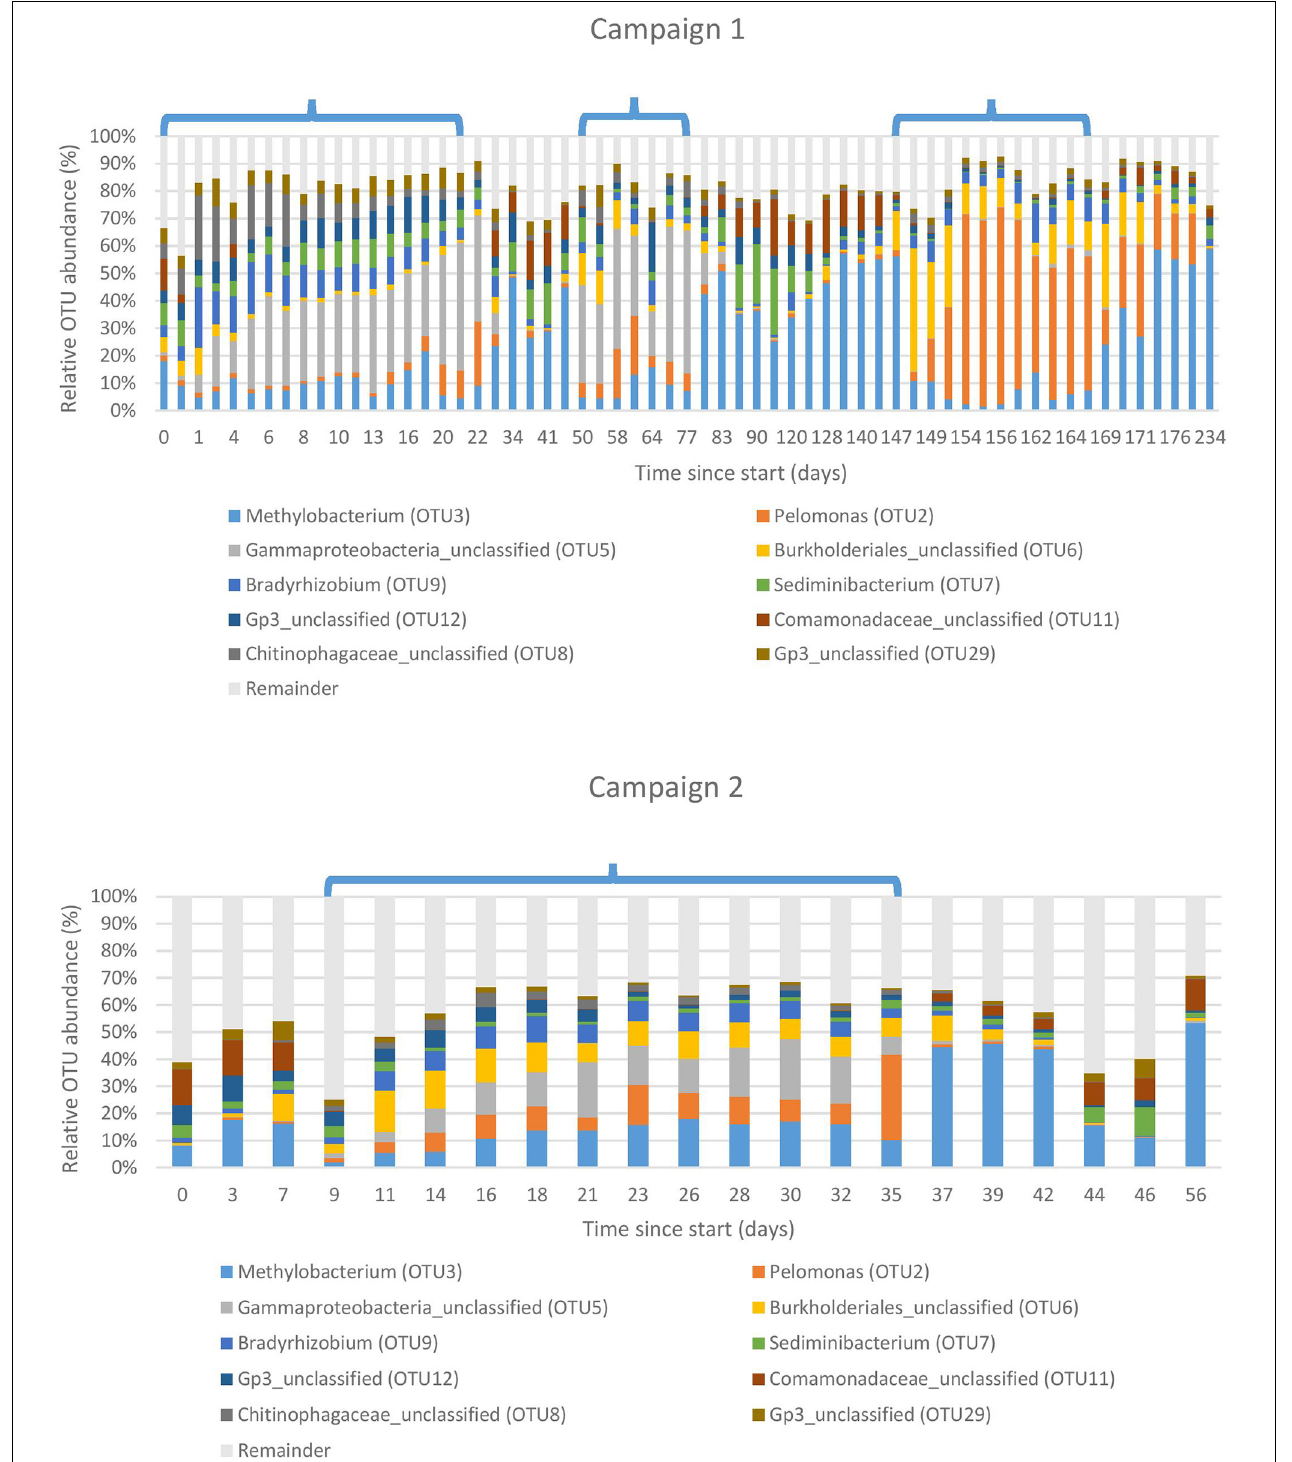
FIGURE 3 | Bacterial community structure of the basin water environment. Ten most abundant Operational Taxonomic Units (OTUs) displayed in relative abundances. Each OTU is taxonomically assigned at the genus level. Remainder: All remaining OTUs not included in the 10 most abundant ones. Cycles are indicated by brackets, interspersed with shutdown periods. The horizontal axis indicates the number of days since the sampling start. Top: sampling campaign 1 (start-end: 06/09/2016-28/04/2017), bottom: sampling campaign 2 (start-end: 16/04/2018-11/06/2018).